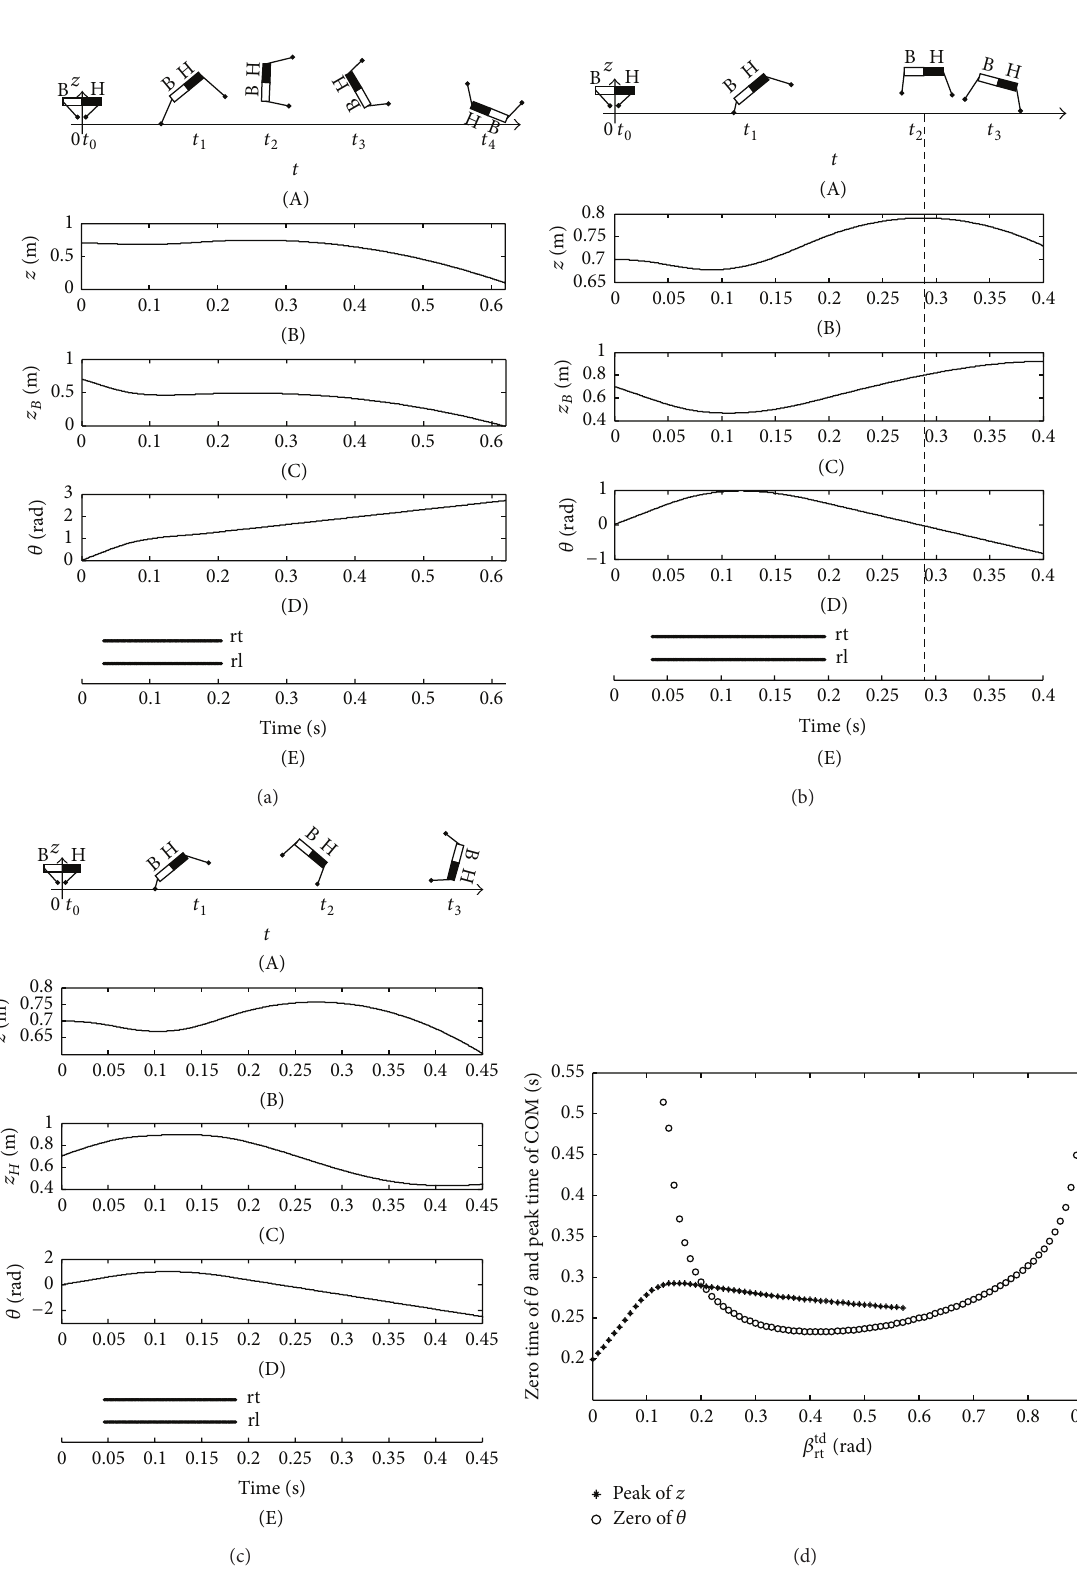
= 0 . 39 rad; (d) the zero time of pitching angle and the peak time of rt